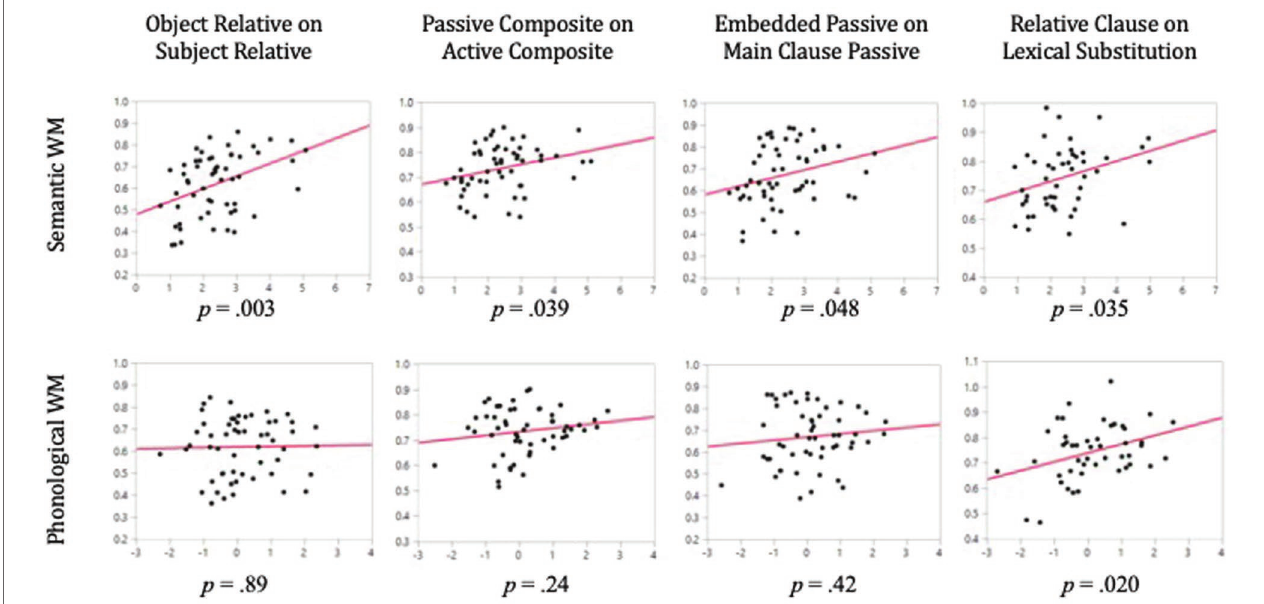
FIGURE 5 | Effect leverage plots for the individual contributions of semantic and phonological WM in four models predicting performance on the relative clause sentence comprehension task. In all plots, the Y -axis represents sentence comprehension performance after all other effects included in the model have been factored out. The X -axis represents WM performance (semantic WM along the top row and phonological WM along the bottom) after all other effects included in the model have been factored out.